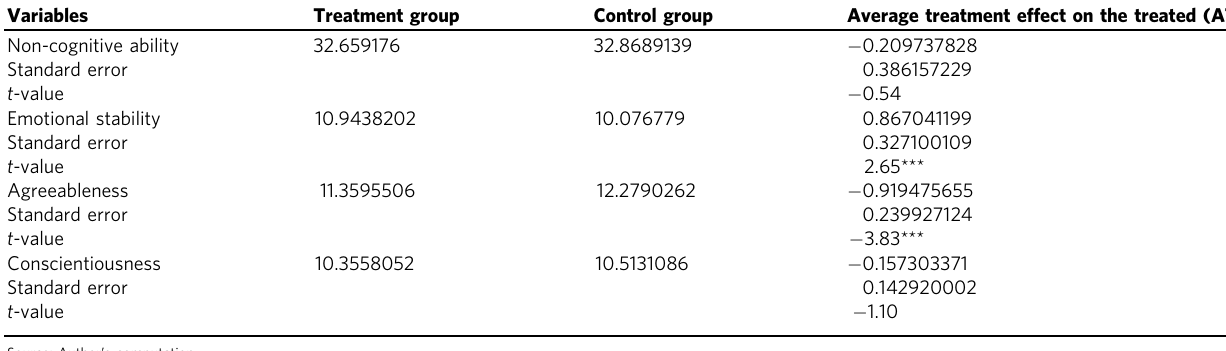
Table 9 The results from the PSM exercise for both parents migrating